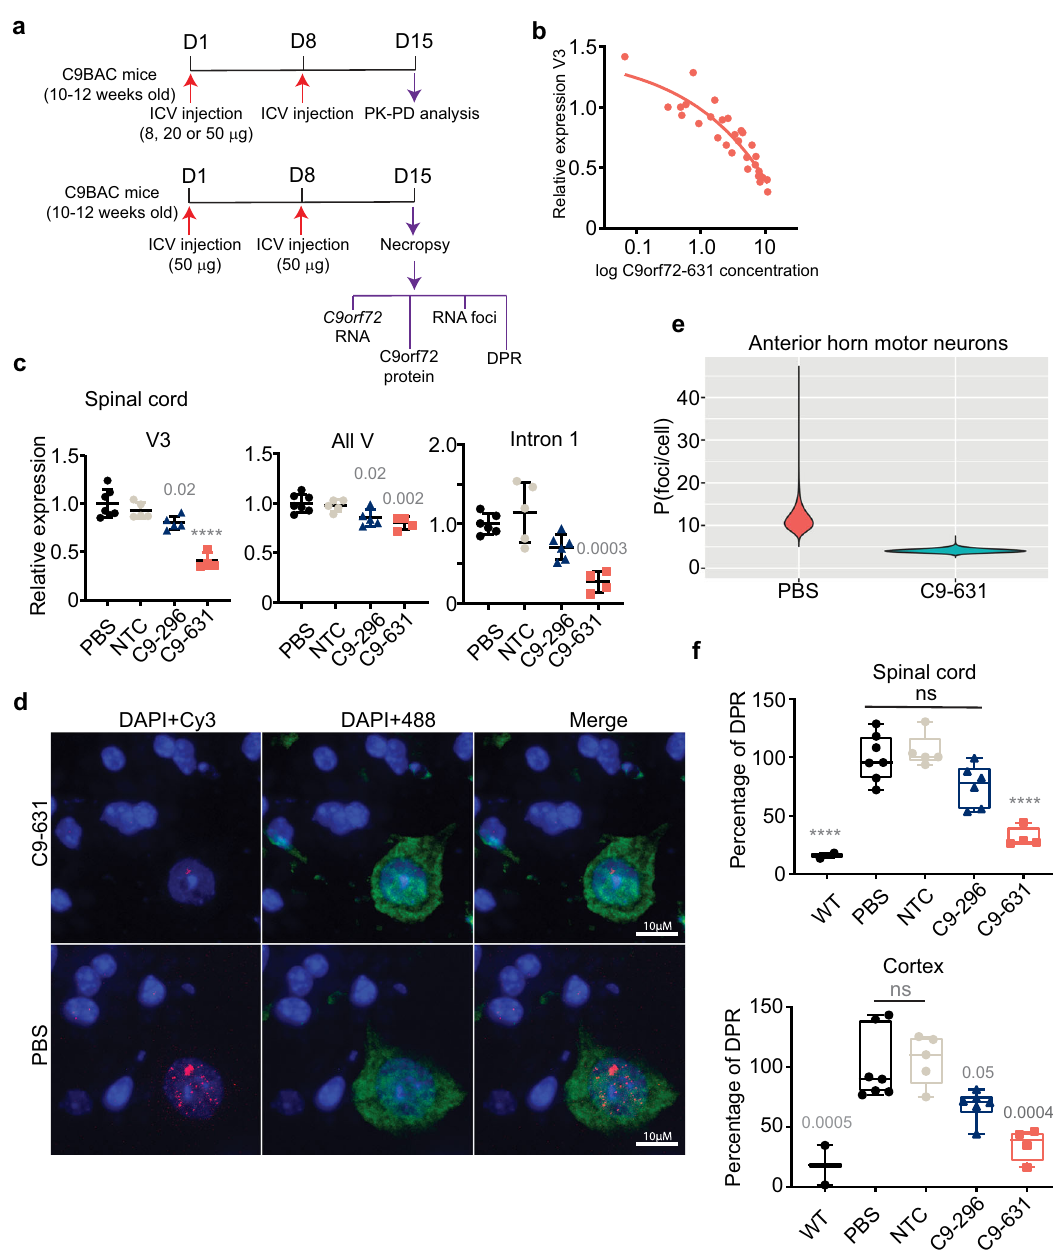
Fig. 4 Stereopure oligonucleotides lead to the preferential reduction of repeat-containing transcripts, RNA foci, and DPR proteins in C9BAC mice. a Schematic representation for dosing regimens: single-dose escalation study for panel b (top), and 2-week study for panels c – f (bottom). For both regimens, animals received the same dose in both ICV injections on days (D) 1 and 8. Assays performed at necropsy are indicated. b Relative V3 expression (standardized to Hprt ) is plotted with respect to the log concentration of C9orf72-631 in the spinal cord. c Relative expression levels for V3 (left) all variants (All V, middle) and intron 1-containing transcripts (right) in spinal cord are shown for the indicated oligonucleotide. Expression is standardized to Hprt , individual points indicate data from one mouse, Data are presented as mean ± SD. One-way ANOVA with Dunnett ’ s multiple comparisons test. Exact P values are indicated on graph, **** P < 0.0001. d Representative images from the evaluation of four mice per treatment group, showing spinal cords of mice treated with C9orf72-631 (top) or PBS (bottom) and stained for RNA foci (Cy3-labeled probe, red), nuclei (DAPI, blue), and motor neurons (anti-NeuN, green). 10 μ m scale bars are shown. e Quanti fi cation of RNA foci per cell in anterior horn motor neurons in mice treated with PBS (fuschia) or C9orf72-631 (aqua) (Supplementary Fig. 7). f Percentage of RAN-translated DPR protein (polyGP) in neurons from the spinal cord (top) or cortex (bottom) is shown for the indicated treatment (WT untreated n = 2; PBS treated n = 7; C9orf72-296-treated n = 6; C9orf72-631 n = 4). Boxes delineate minima and maxima with horizontal lines denoting means. One-way ANOVA with Dunnett ’ s multiple comparisons test. Exact P values are indicated on graphs, **** P < 0.0001, ns non-signi fi cant. Source data are provided as a Source Data fi le. ICV intracerebroventricular, PBS phosphate-buffered saline, NTC non-targeting control, All V all variants, DPR dipeptide repeat, WT wild-type